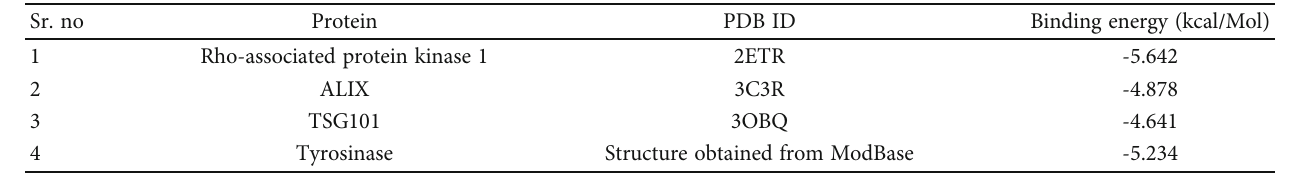
Table 4: Molecular docking scores of compound 1 against selected